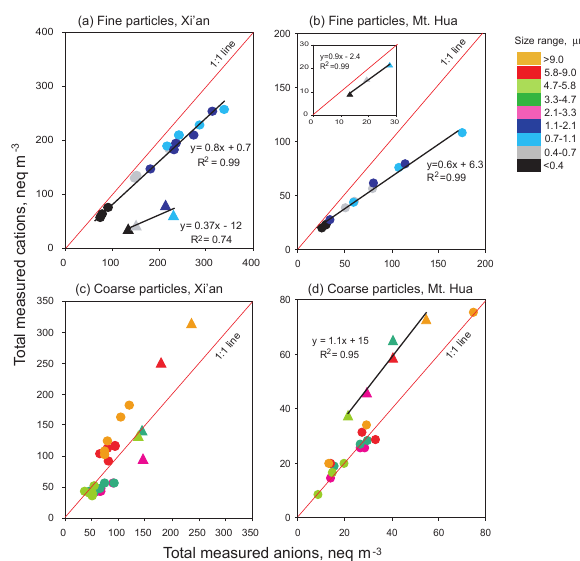
Total measured anions, neq m -3